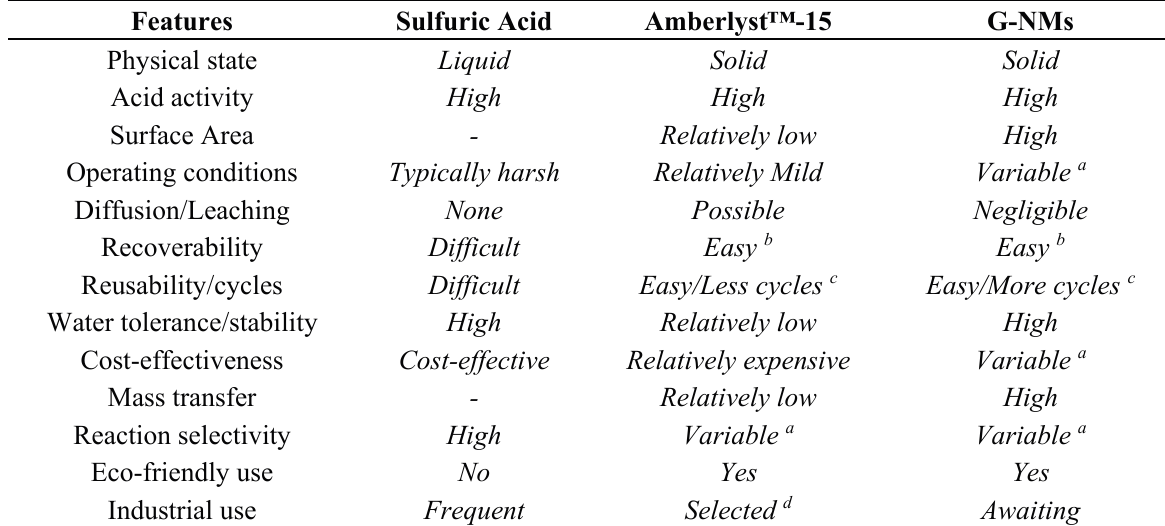
Table 1. A comparison between the characteristic features of sulfuric acid, Amberlyst™-15 and G-NMs in acid